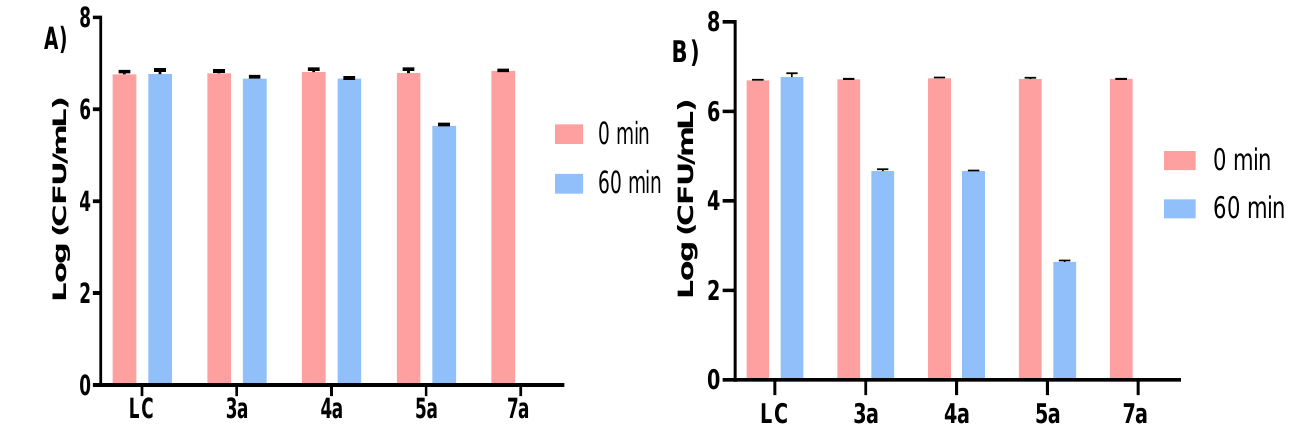
Figure 5. Photodynamic inactivation of bioluminescent E. coli treated with PSs 3a – 5a and 7a at 5.0 µ M after 60 min of white light irradiation at an irradiance of ( A ) 25 mW cm − 2 and ( B ) 50 mW cm − 2 . The values are expressed as the means of three independent experiments; error bars indicate the standard deviation.